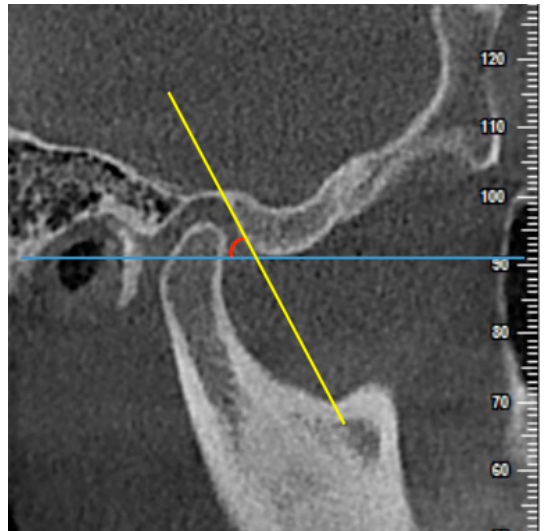
Figure 3. The measurement of articular eminence inclination (AEI) using the best-fit line method (AEI-BFL) on the central sagittal slice. The angle between the tangent line drawn to the posterior slope of the articular eminence (yellow line) and a line parallel to the Frankfort horizontal (FH) plane (blue line) was measured.